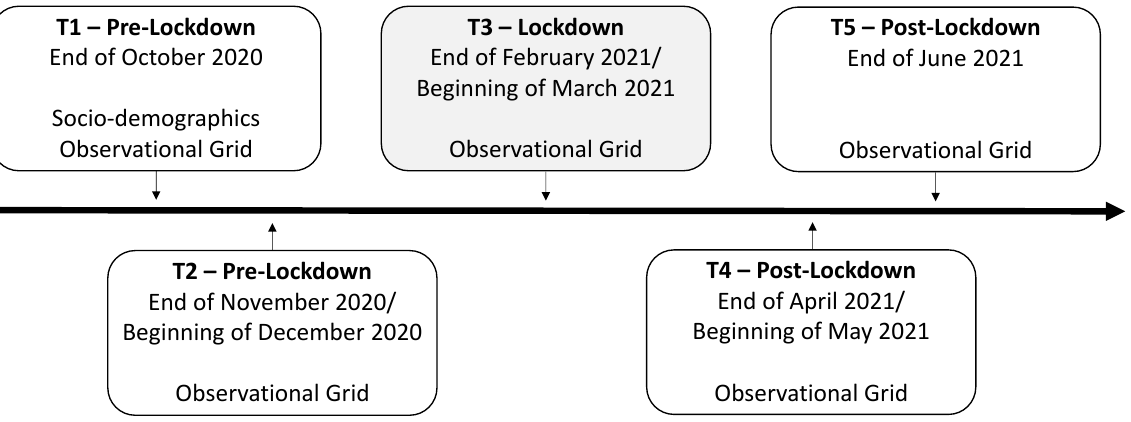
Figure 3. Data collection timeline: time frame for each data collection (T1–T5), classification into pre-, during, and post-second lockdown, and instruments collected in each